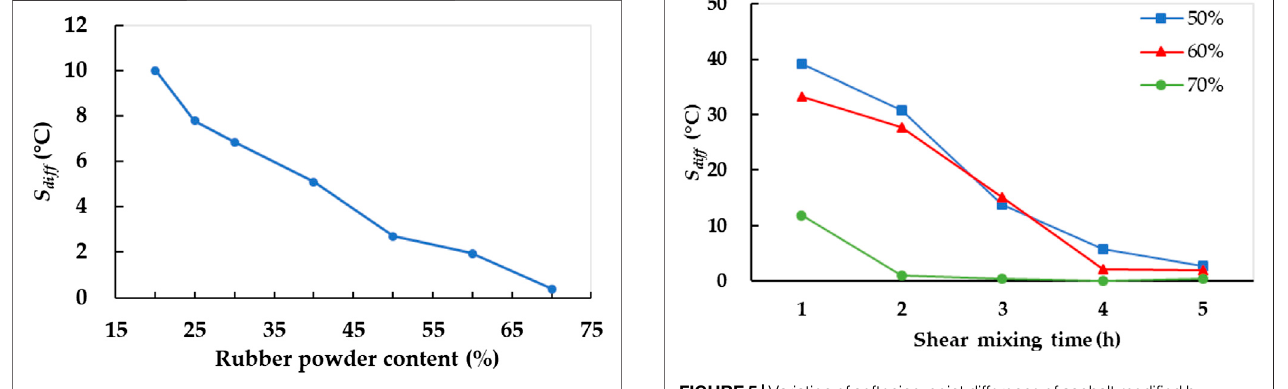
FIGURE 4 | Variation of softening-point difference with content.